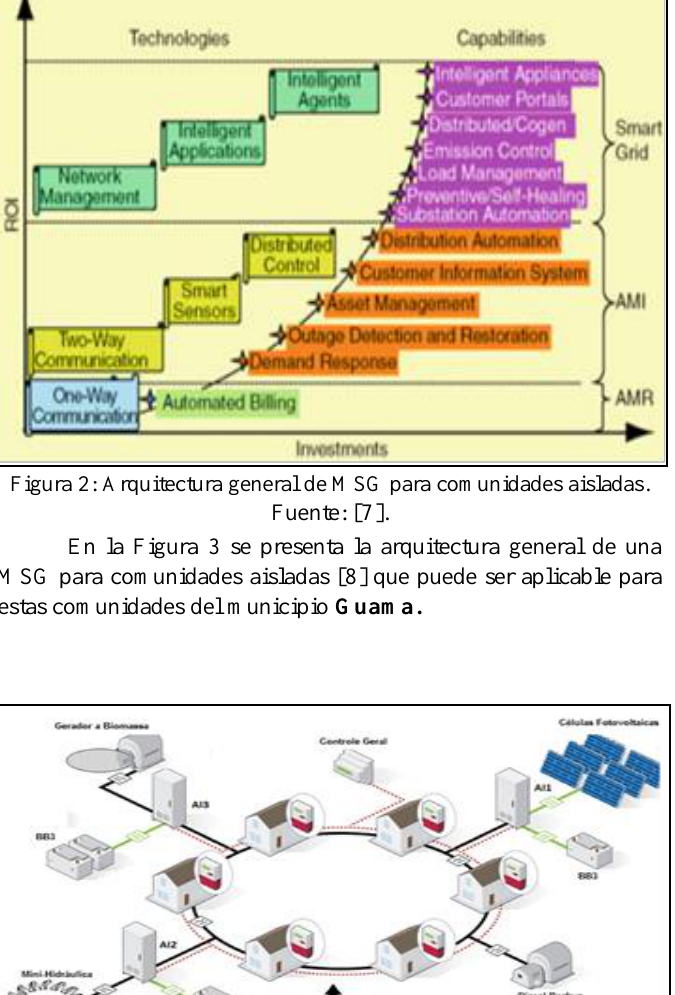
Figura 3: Arquitectura general de MSG para comunidades aisladas. Fuente: [9].